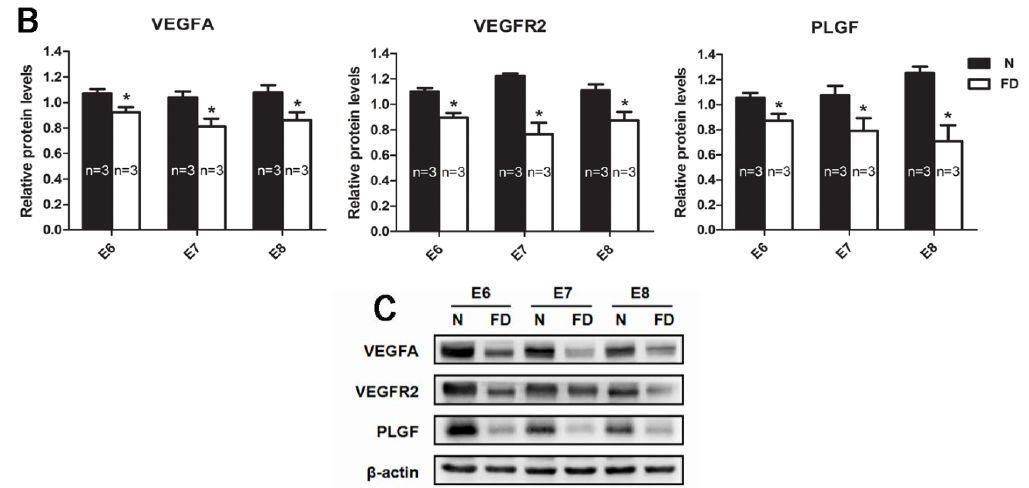
Figure 4. Real-time polymerase chain reaction (RT-PCR) and western blot analysis of the expression of vascular endothelial growth factor A (VEGFA), vascular endothelial growth factor receptor 2 (VEGFR2), and placental growth factor (PLGF) from Embryonic day 6 (E6) to Embryonic day 8 (E8). ( A ) The mRNA levels of VEGFA, VEGFR2, and PLGF in folate-deficient mice were significantly decreased compared with normal mice from E6 to E8 ( ** p < 0.01). Data are presented as the mean ± standard error of the mean (SEM). ( B ) Protein levels in folate-deficient mice were compared with normal mice. Statistical analysis of protein expression was from three independent experiments ( * p < 0.05). Data are presented as the mean ± SEM. ( C ) Western blot analysis of three angiogenic growth factors. β-actin was used as a loading control. The protein levels of VEGFA, VEGFR2, and PLGF